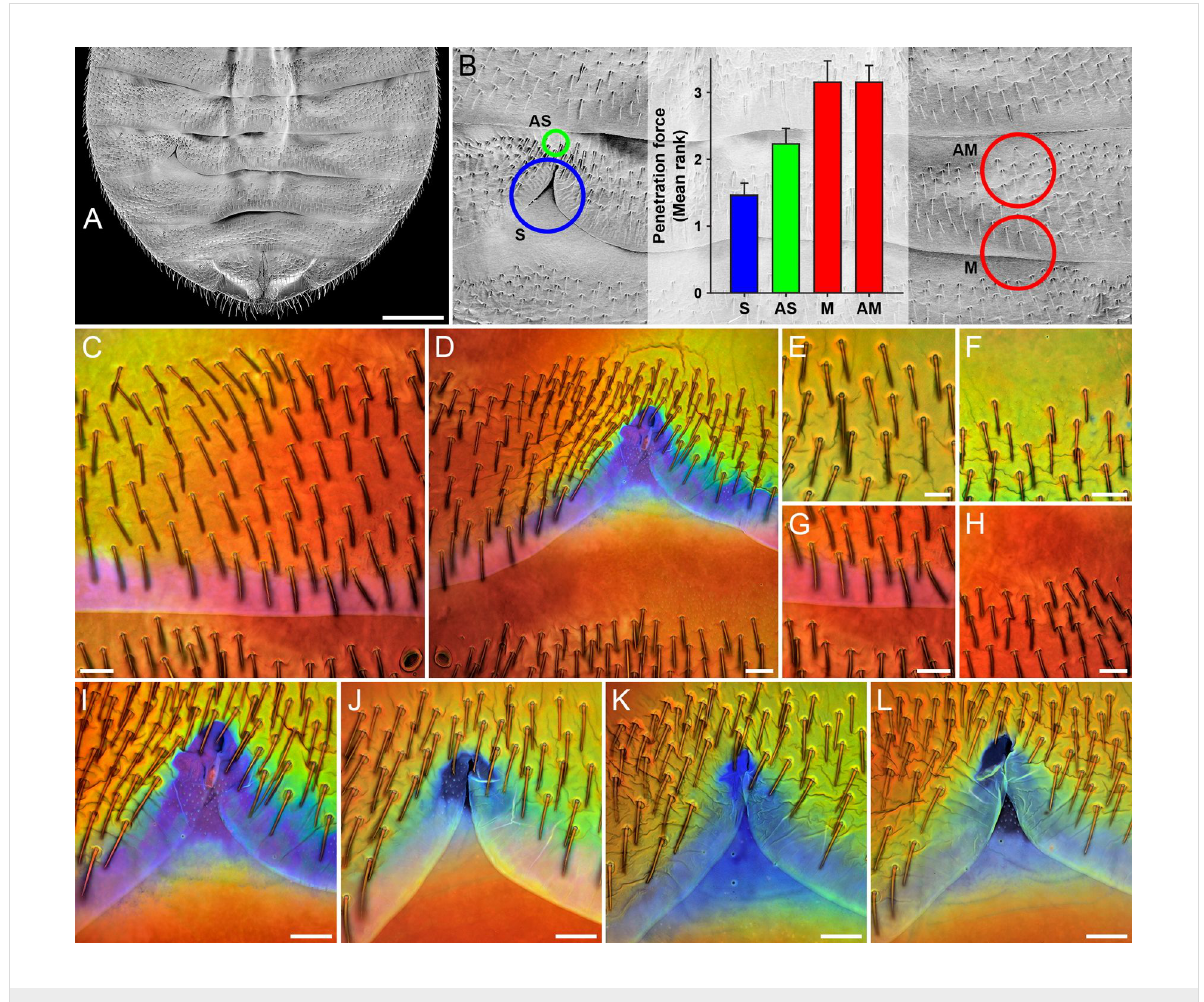
Figure 8: Material composition and properties of the ventral abdominal cuticle of females of the common bed bug ( Cimex lectularius ). (A) Abdomen overview (scanning electron micrograph). (B) Section of A indicating the locations of the spermalege (S) and three other cuticle areas called AS, M and AM, and penetration forces (mean ranks and standard errors) determined for these four cuticle sites. (C–L) Confocal laser scanning micrographs (maximum intensity projections) showing overlays of different autofluorescences exhibited by the exoskeletons. Blue colours indicate large propor- tions of resilin. (C, D) Autofluorescence composition of the cuticle in the left (C) and right (D) abdomen parts. The dominance of violet/blue autofluo- rescence (shown in blue) is restricted to the spermalege, clearly indicating that only at this site the cuticle contains large proportions of resilin. (E–H) Autofluorescence composition of the cuticle at the sites AS (E, F), M (G) and AM (H). The cuticle at M and AM consists mainly of sclerotised chitinous material, indicated by the dominance of autofluorescence shown in red, while the presence of large proportions of autofluorescence shown in green in the cuticle at AS indicates that the respective material consists mainly of weakly or non-sclerotised chitinous material. (I–L) Autofluorescence compo- sition of the cuticle at the spermaleges of different one-week-old females, indicating variation of the extent of the resilin-dominated spermalege struc- tures between females. Scale bars = 500 µm (A), 50 µm (C, D, F–L), 25 µm (E). Figure reproduced with permission from